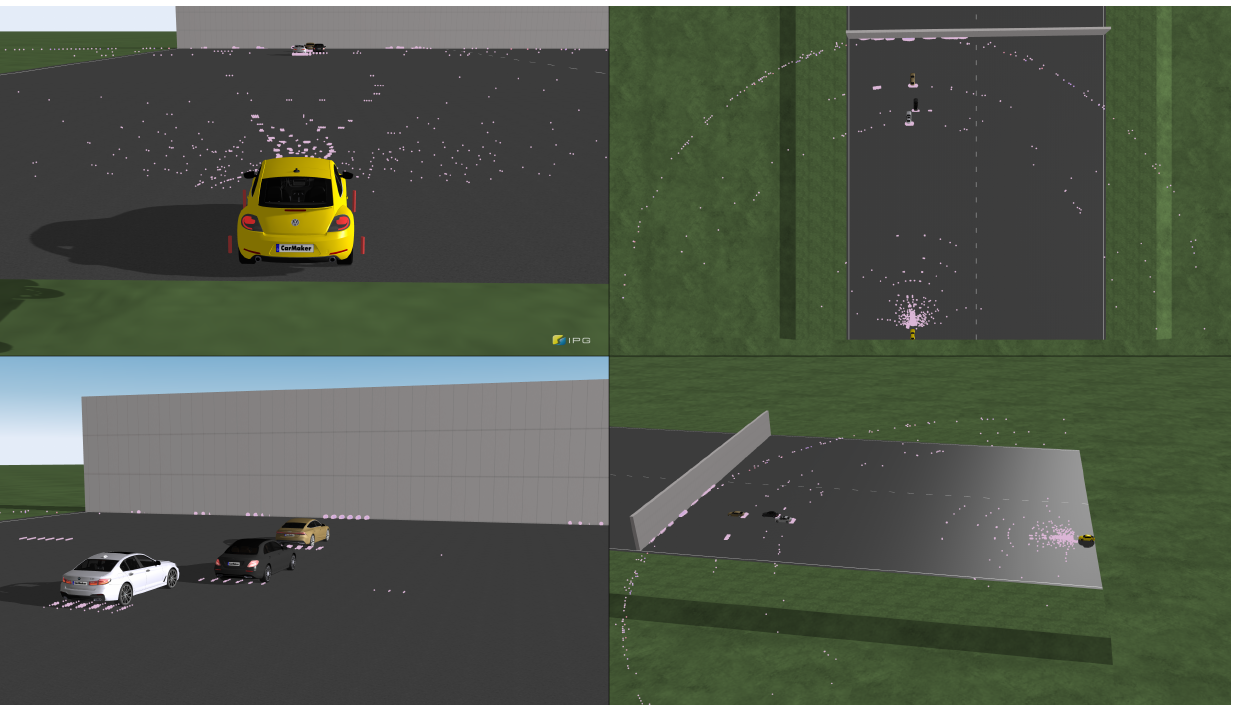
Figure 7. Measurement scenario with radar model